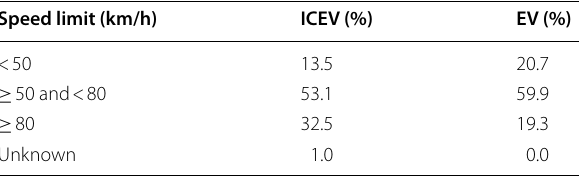
Table 3 Distributions of crashes by speed limit